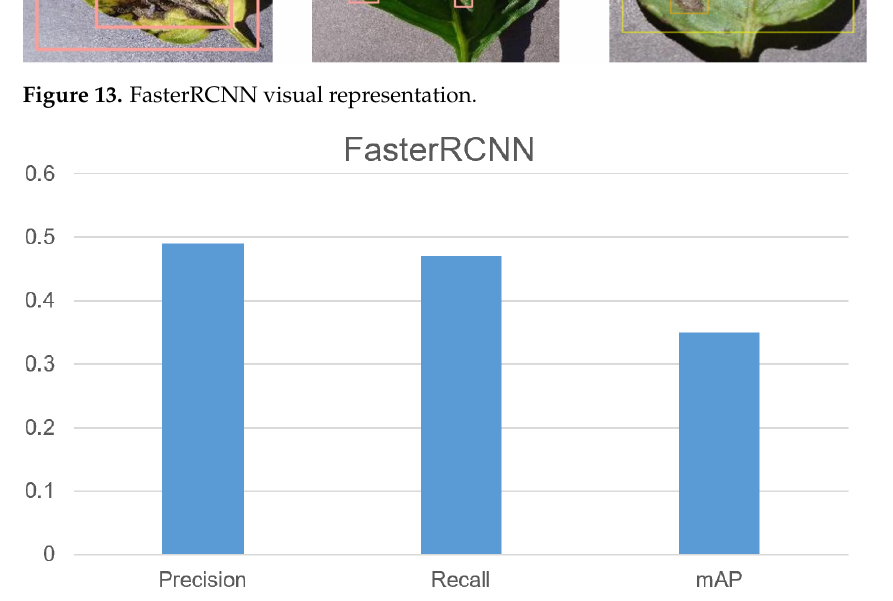
Figure 14. FasterRCNN comparison graph.